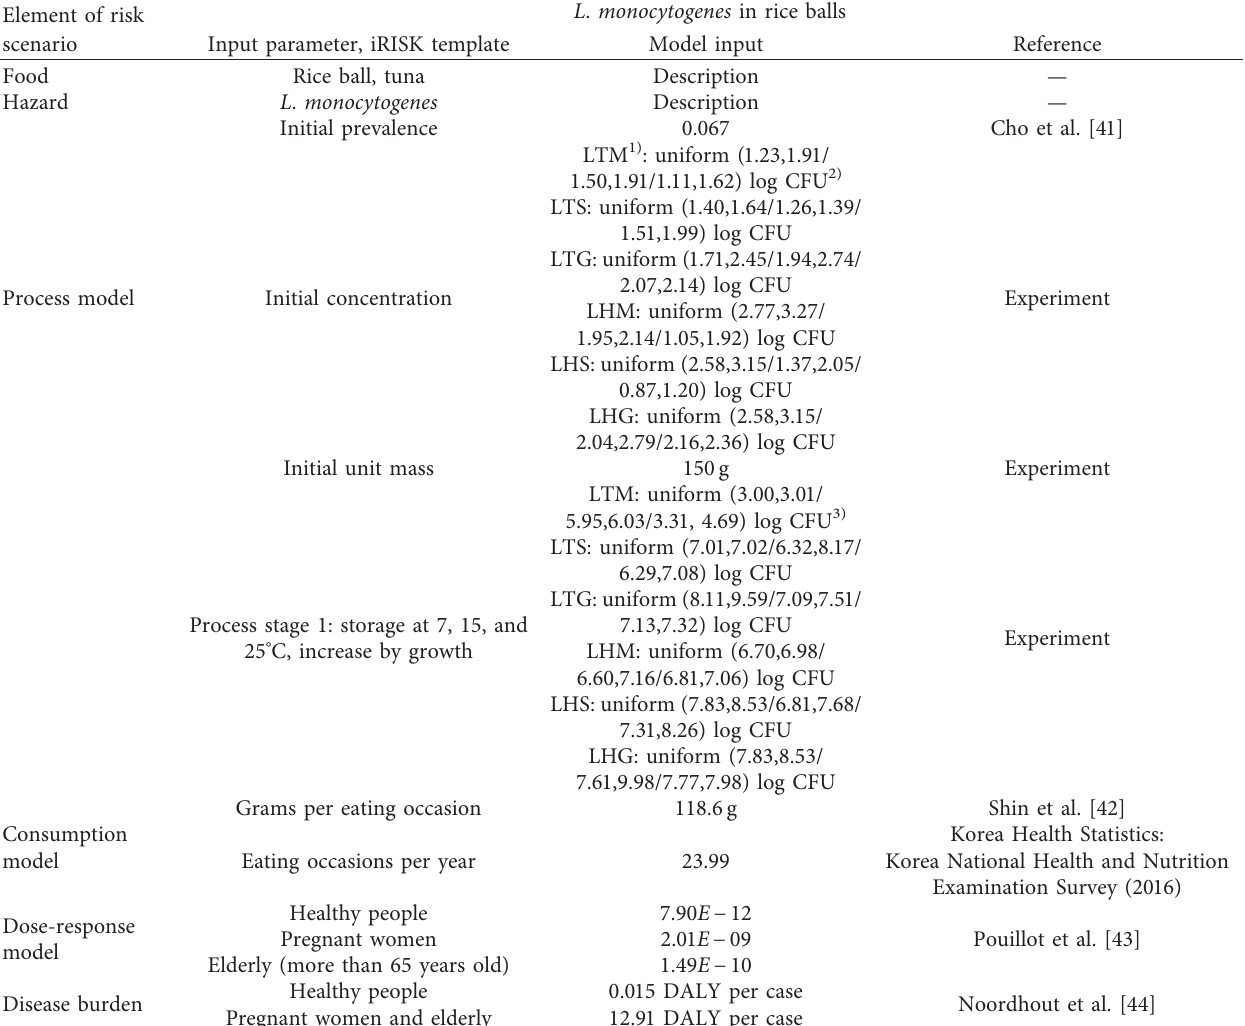
Table 2: Model inputs for food scenarios of L . monocytogenes in rice balls in FDA-iRISK